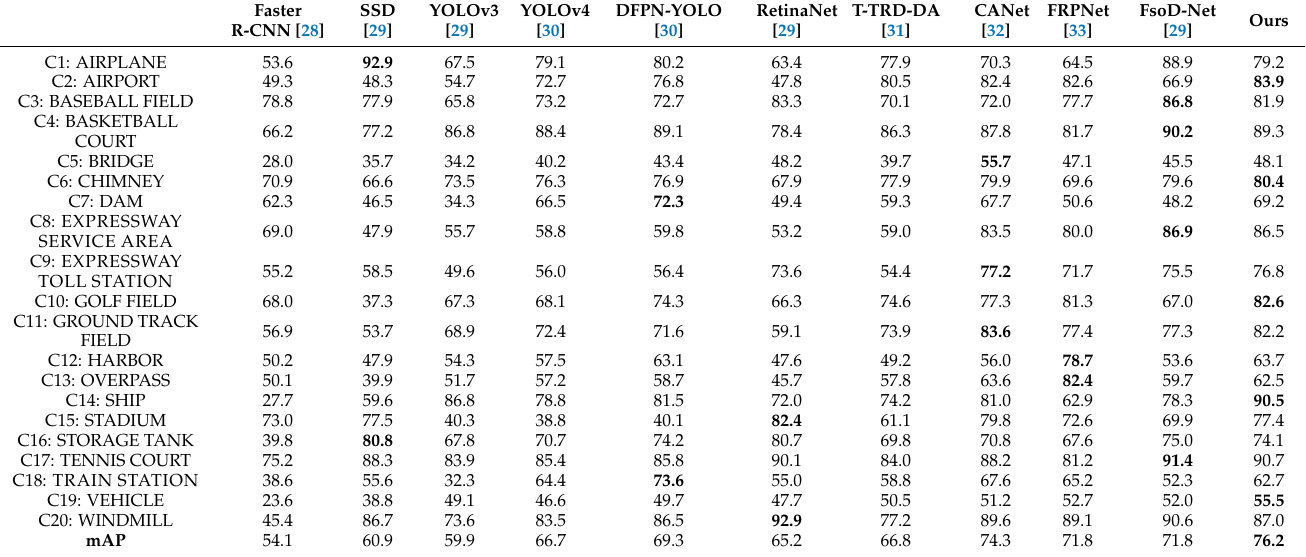
Table 3. The performance AP and the mAP of different methods on the DIOR test